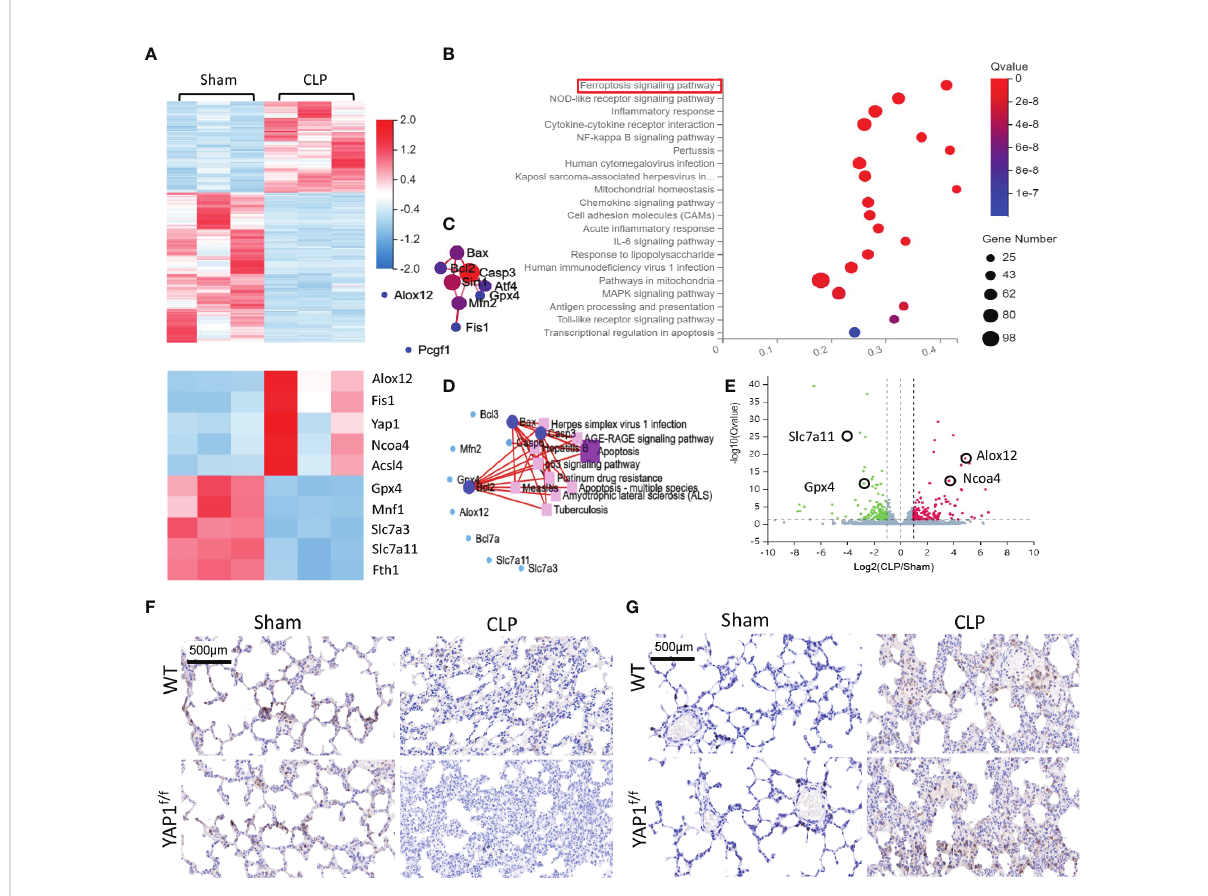
FIGURE 6 Gene expression analysis of lung tissue in WT+CLP mice and WT+Sham mice. (A) Hierarchical clustered heatmap of differentially expressed genes (DEGs) in lung tissues between WT+CLP mice and WT+Sham mice, n = 3. (B) The Kyoto Encyclopedia of Genes and Genomes enrichment analysis (KEGG pathway) was adopted to identify the most signi fi cantly altered signaling pathways in lung tissues of CLP mice. The differentially expressed genes enriched in the ferroptosis-related pathway, indicating that the ferroptosis signaling pathway was obviously activated, n = 3. (C) Construction of protein – protein interaction (PPI) regulatory network based on DEGs. (D) Network of KEGG pathway based on similarity of their gene expression pro fi les. These enrichment genes were related to several signaling pathways. (E) The volcano plot shows DEGs between CLP mice and WT mice. Genes colored in red represented dramatically upregulated genes, genes colored in green displayed remarkably downregulated genes, while insigni fi cantly altered genes are colored in gray, log2 FC > 1, Q value < 0.05. (F) SLC7A11 of mouse lung parenchyma was stained by immunohistochemical (IHC) staining. (G) NCOA4 of mouse lung parenchyma was stained by IHC